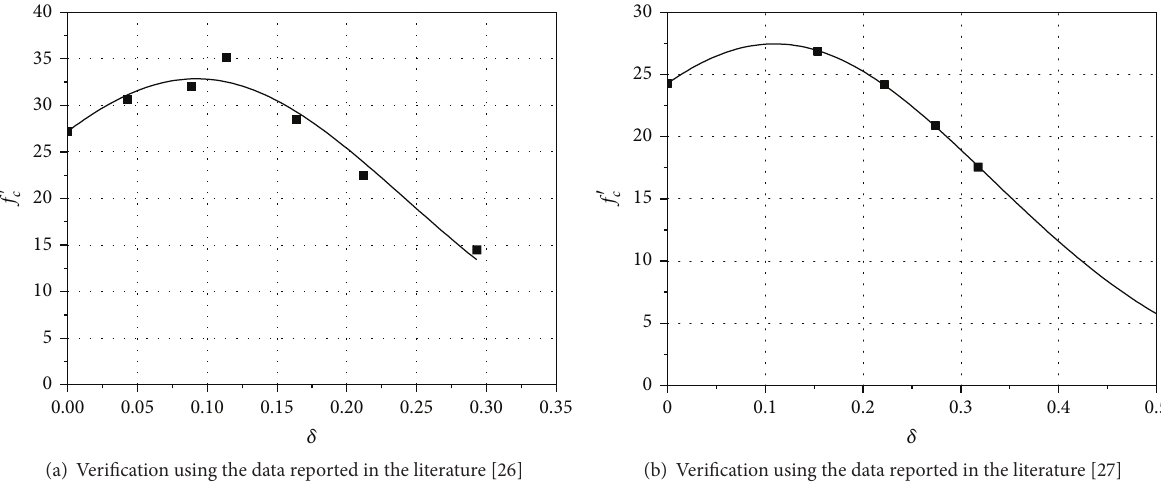
Figure 10: Verification of the average strength deterioration model by the existing experimental data.